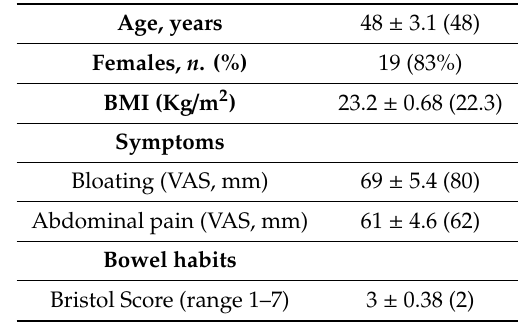
Table 1. Baseline characteristics of the study patients ( N = 23).